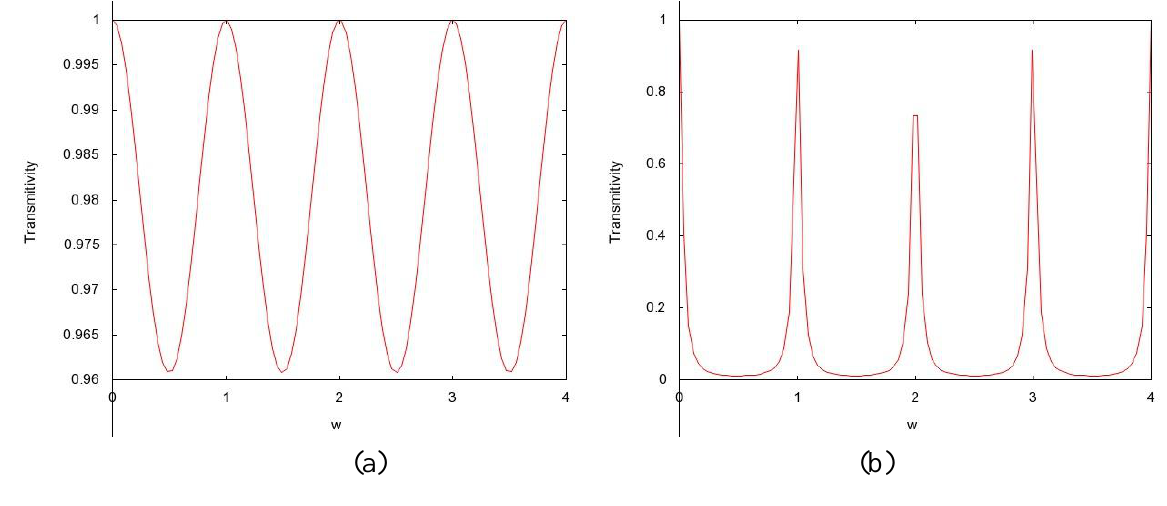
Figure 8. Transmitivity 𝒯 𝜔 (a) and R